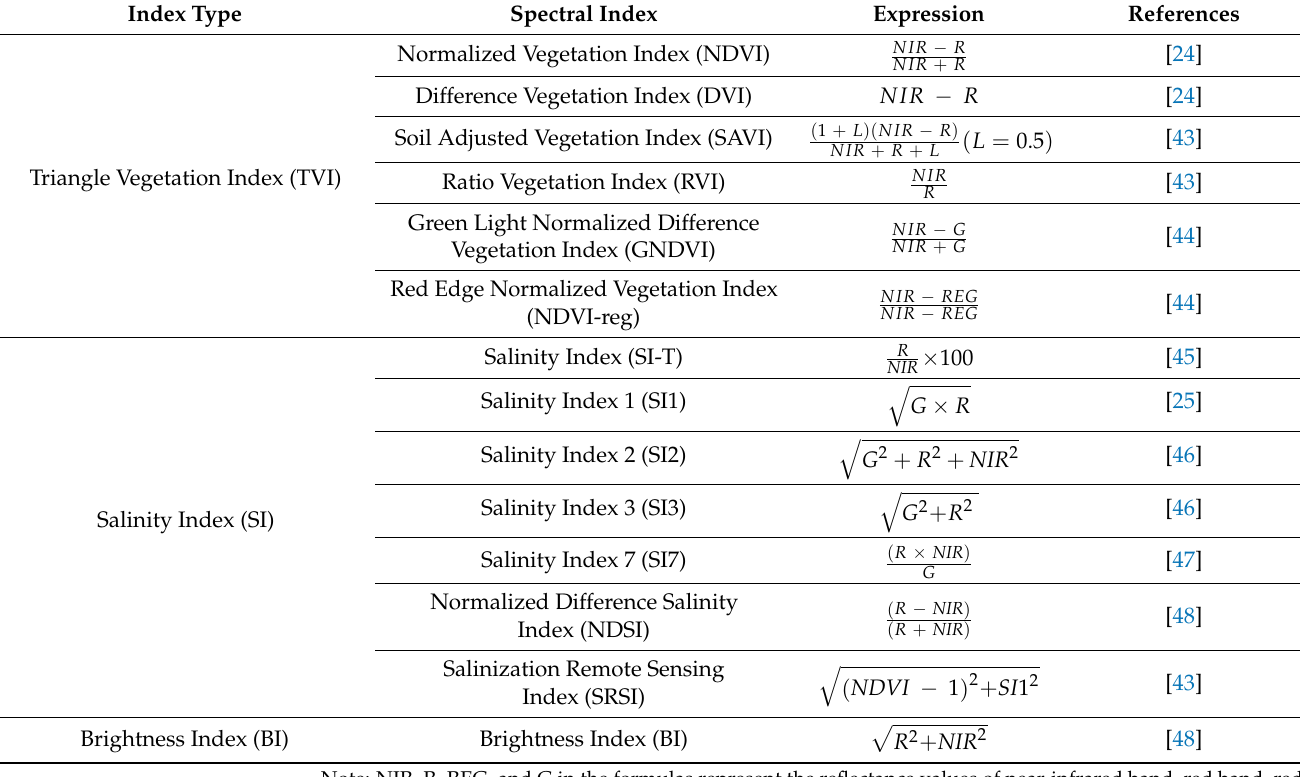
Table 2. Spectral indexes and related